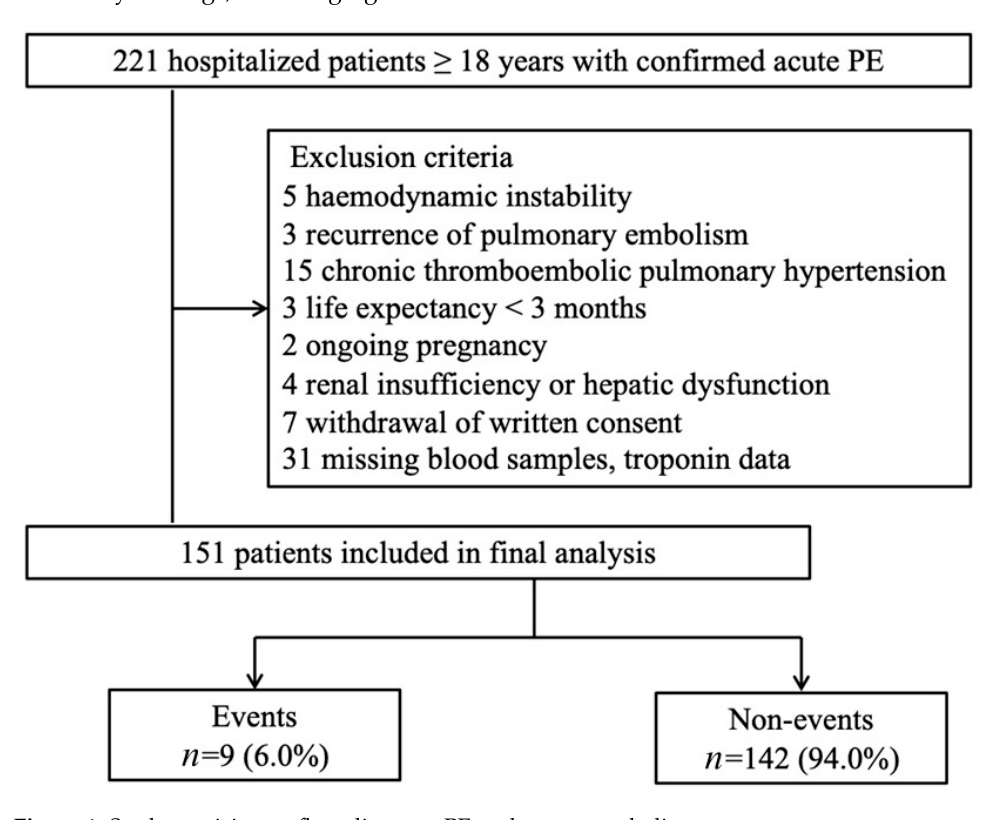
Figure 1. Study participants flow diagram. PE, pulmonary embolism.